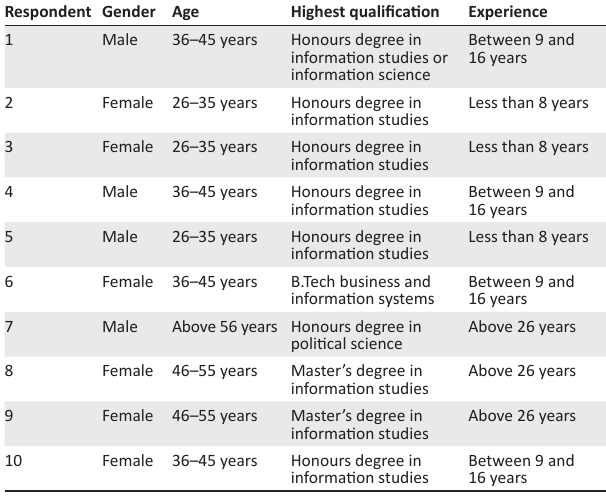
TABLE 1: Demographic profile of